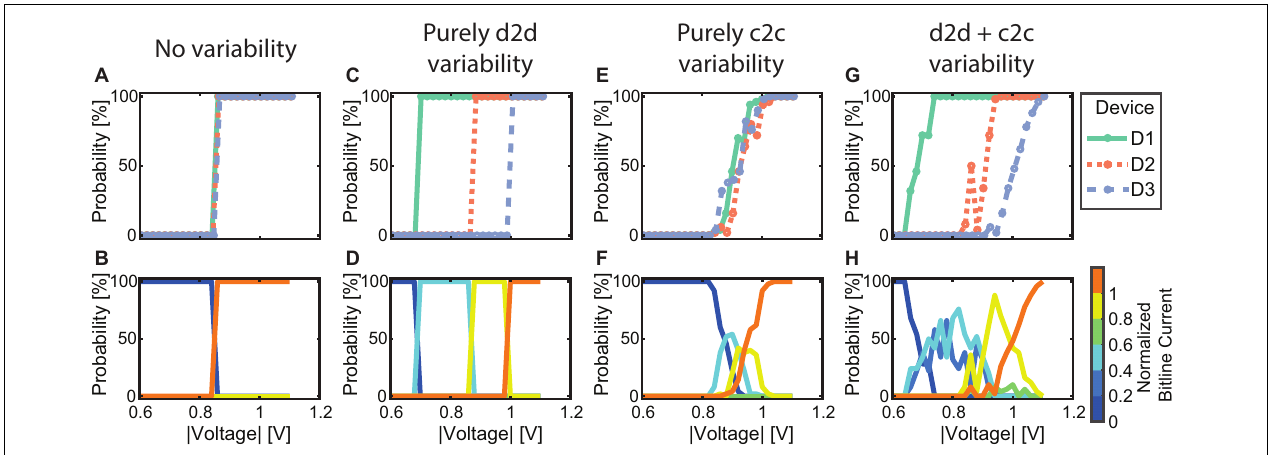
FIGURE 6 | Simulation of different synapse behavior to showcase the relation between SET probability traces of individual devices (upper row) and probabilities for the achieved bitline currents (lower row) by adapting the compact model. (A,B) Represent three identical deterministically behaving devices. (C,D) Show three different but deterministic devices. (E,F) Show three identical but probabilistically behaving devices and (G,H) show three different and probabilistic devices.